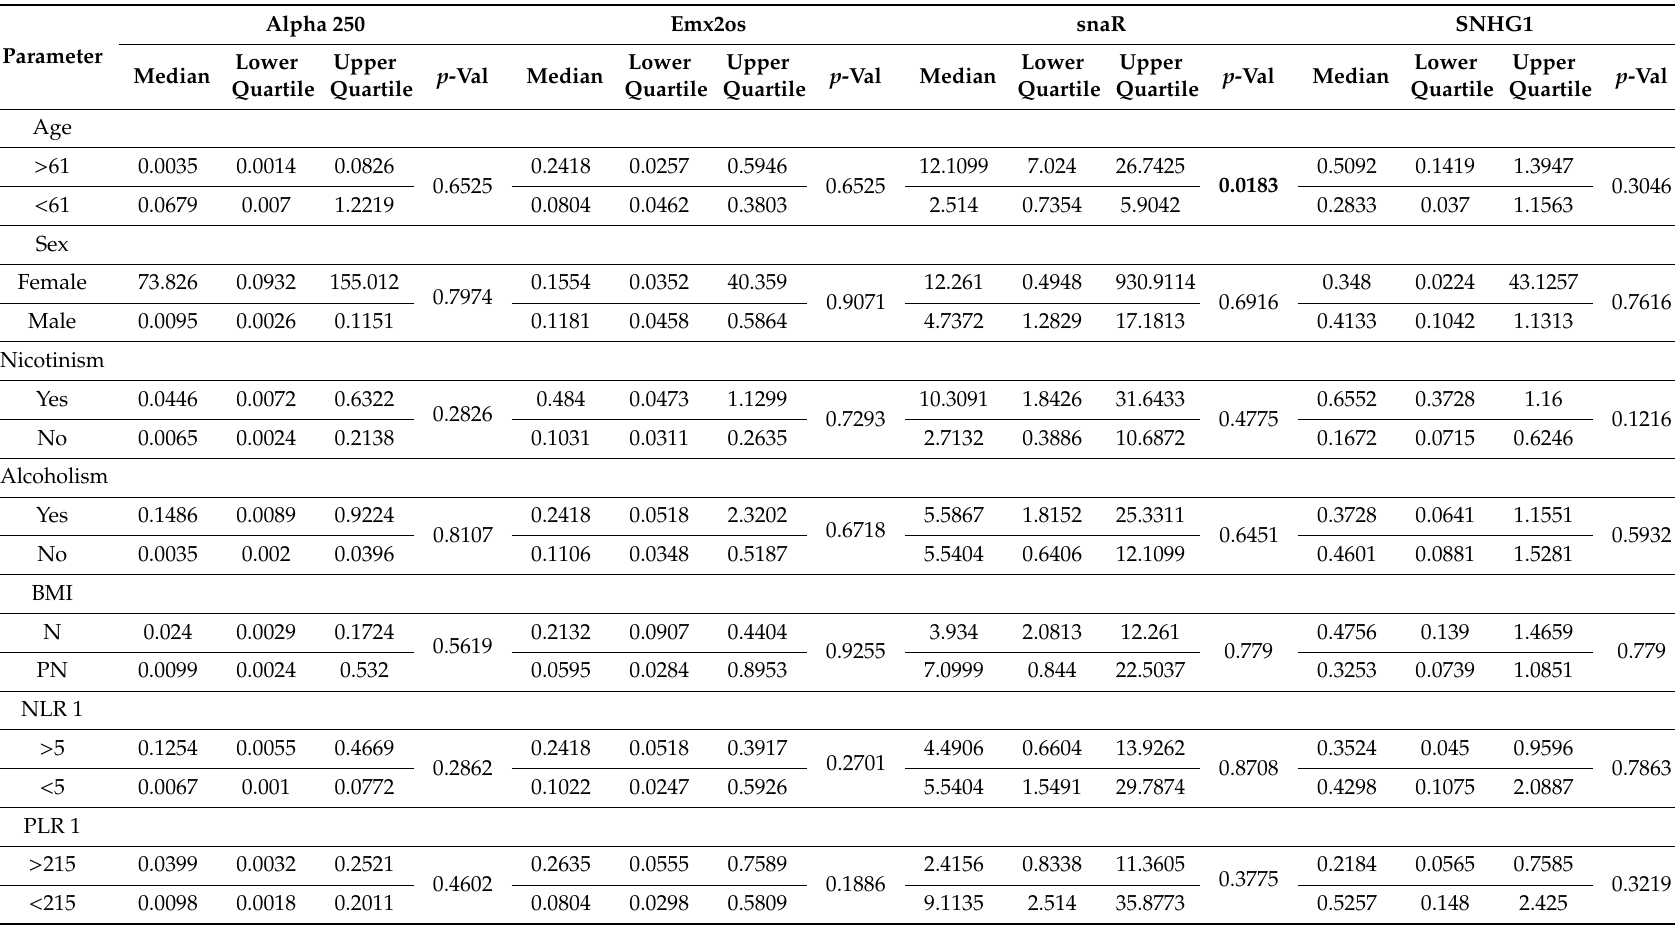
Table 3. Expression levels of Alpha 250, Emx2os, snaR and SNHG1 lncRNAs depending on clinical and laboratory parameters in HNSCC patients; N—BMI